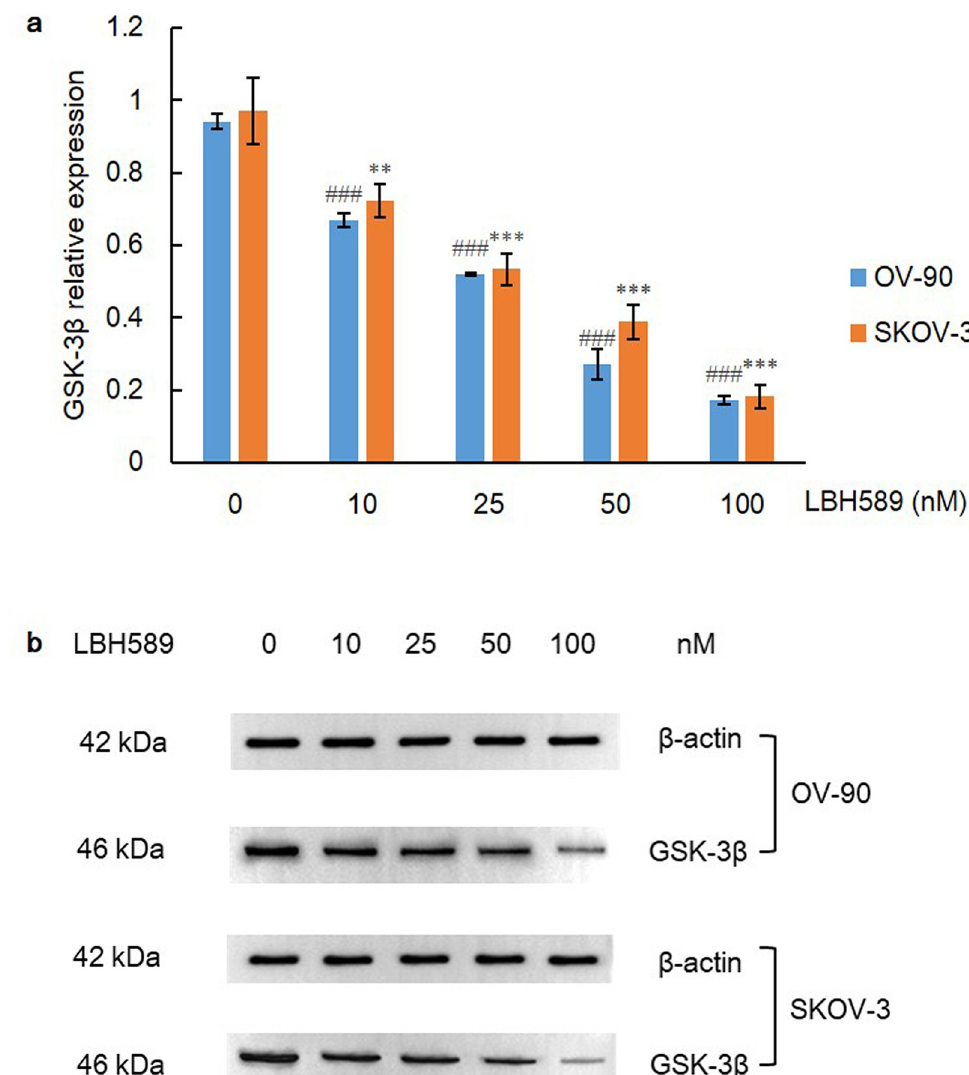
Fig 4. GSK3 β expression after LBH589 treatment for 48 h. A) LBH589 suppresses expression of GSK3 β in OV-90 and SKOV-3 cell lines. Data are shown as mean ± SD of at least three individual experiments. ( � P < 0.05, �� P < 0.01, ��� P < 0.001 vs. SKOV-3 control (0.1% DMSO); # P < 0.05, ## P < 0.01, ### P < 0.001 vs. OV-90 control (0.1% DMSO)). B) The expression of GSK3 β was assessed by western blot analysis after LBH589 treatment for 48 h. The equal protein loading is shown by detection of β -actin. The figures show representative blots which were cropped from original images.